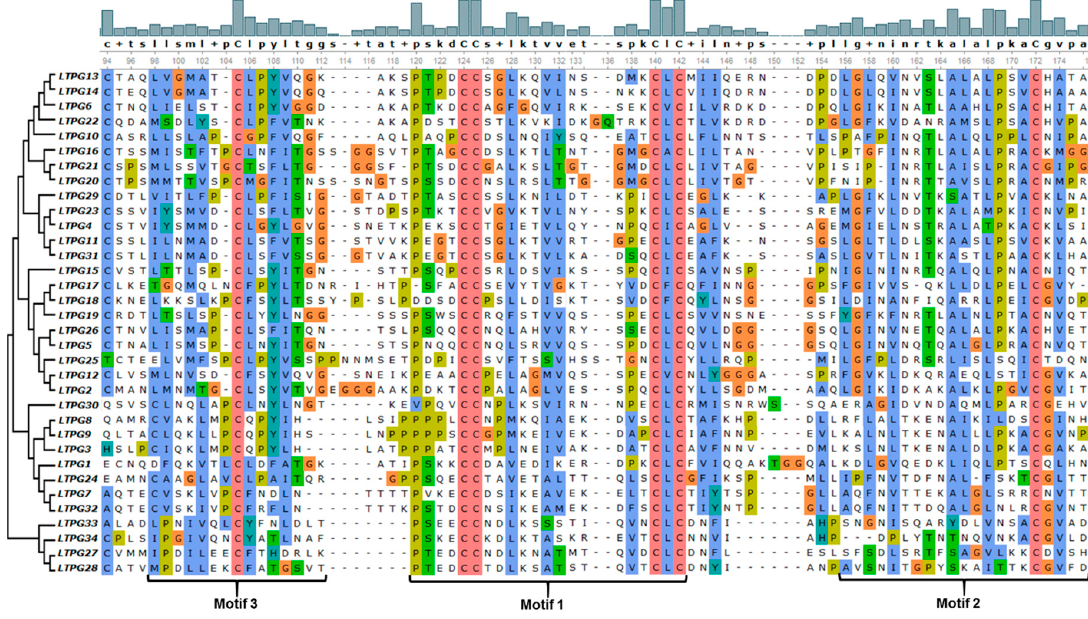
Figure 3. Multiple sequence alignment of the most conserved region of the LTPg proteins comprising the first three motifs.